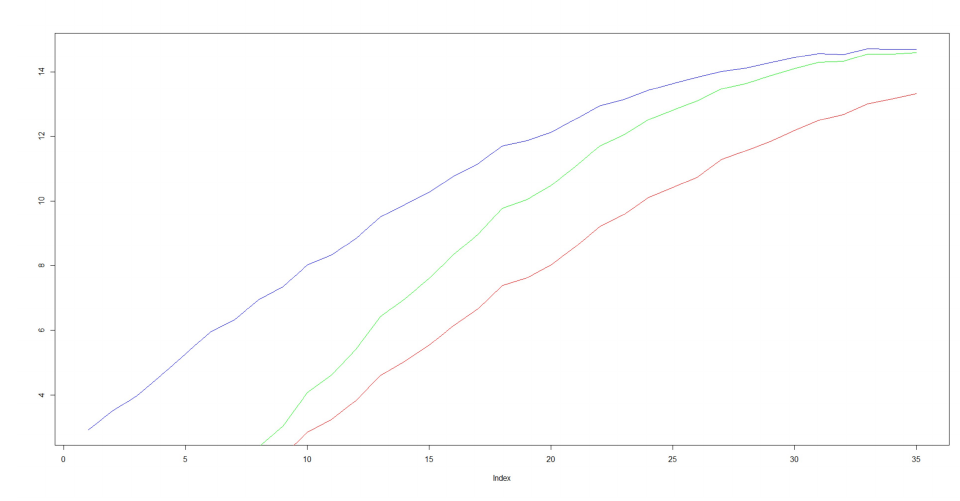
Figure 8. Simulation of variation of κ , ζ , and ν .